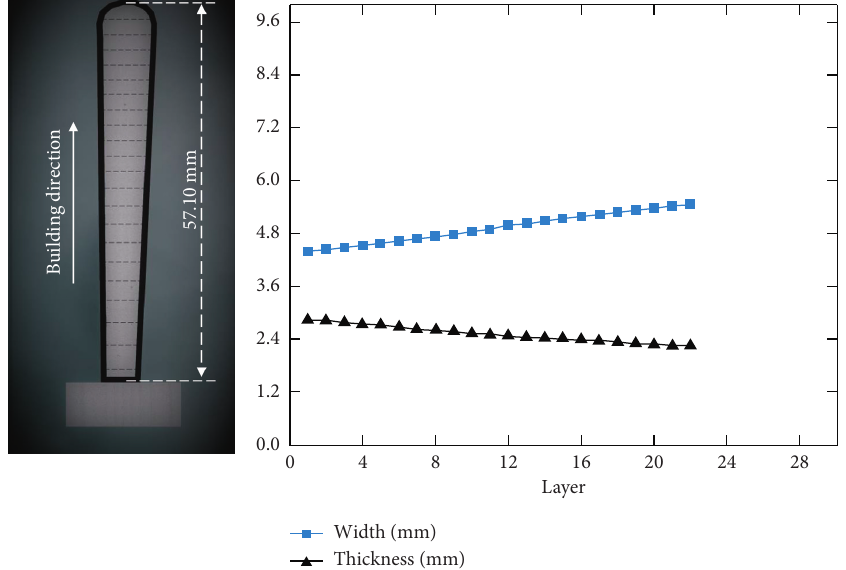
Figure 5: Layer width and thickness of the deposition wall with the copper plates constrained